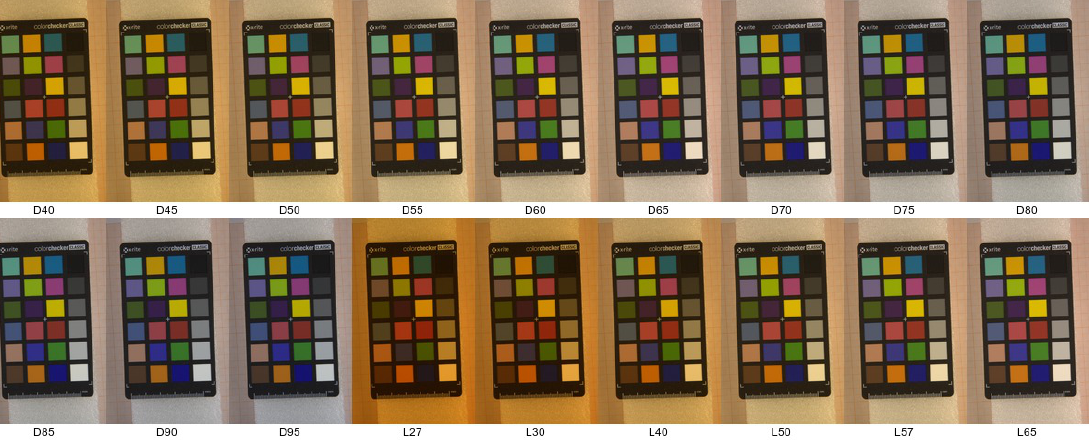
Figure 5. The Macbeth color target, acquired under the 18 lighting conditions considered in this